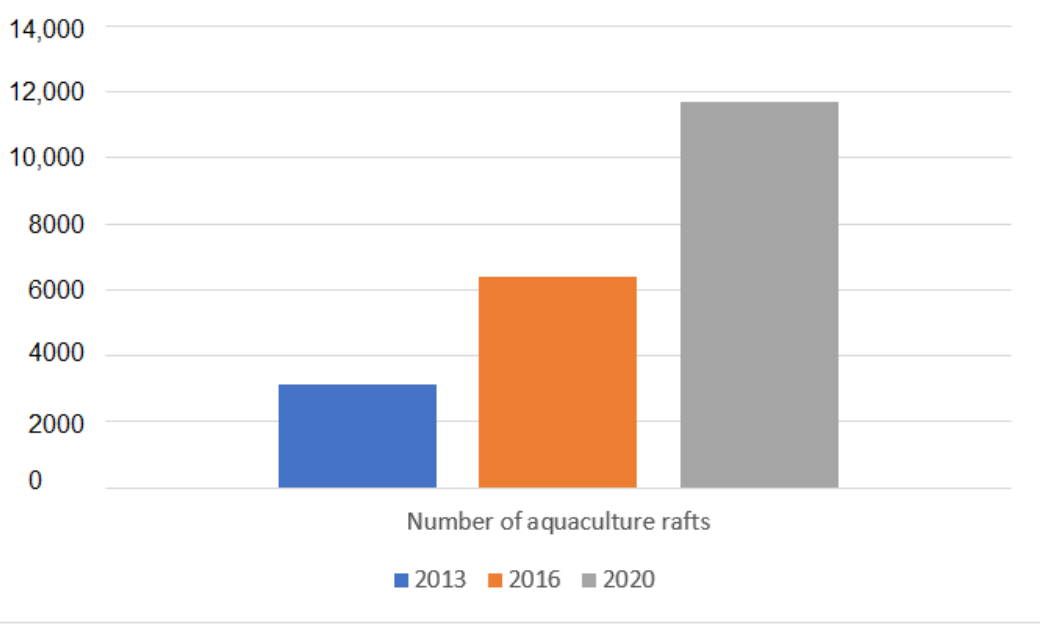
Figure 9. The quantity changes in aquaculture rafts in Haizhou Bay.